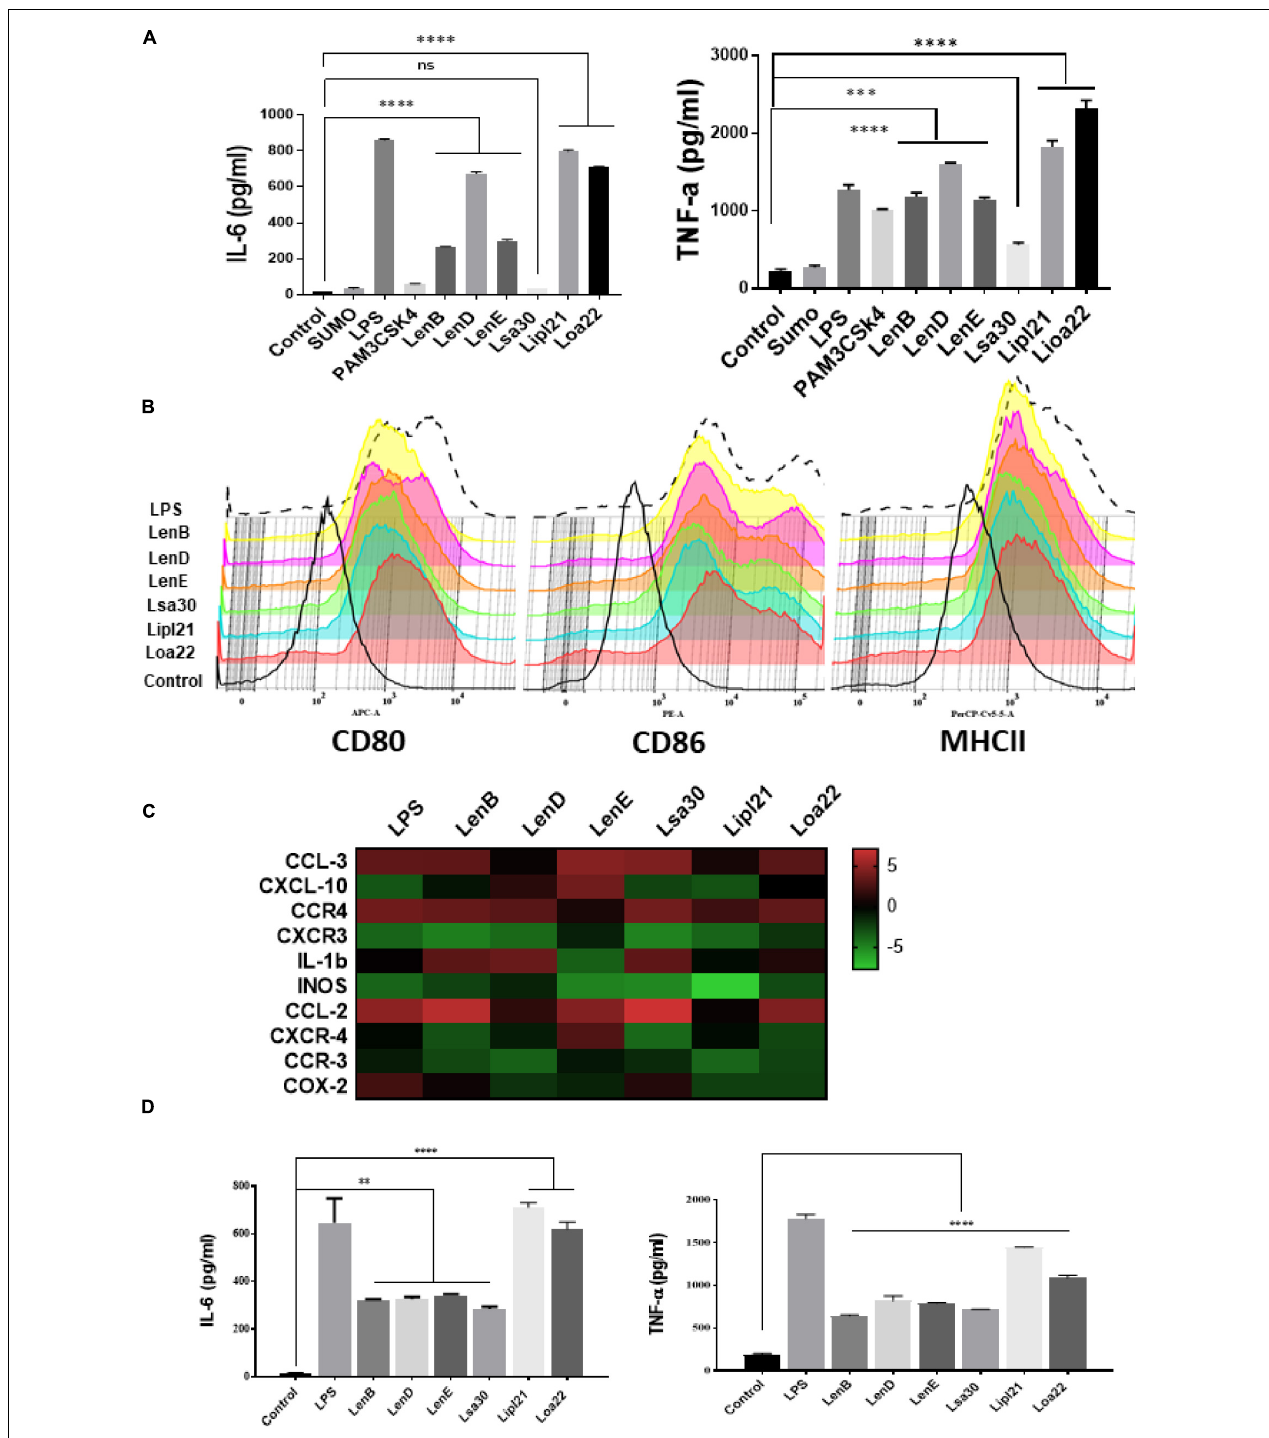
FIGURE 2 | Analysis of activation of mouse macrophages after stimulation with surface proteins. (A) Screening of pro-inflammatory response of surface proteins in RAW264.7 cells by ELISA. RAW264.7 cell lines were stimulated with LPS-treated (500 ng/ml), PAM3CSK4-treated (20 ng/ml), or PMB-treated (1 µ g/ml) rLenB, rLenD, rLenE, rLsa30, rLipl21, rLoa22, or rSUMO for 24 h at 37 ◦ C/5% CO 2 , and supernatant was collected to measure levels of IL-6 and TNF- α using sandwich ELISA kit. (B) Expression of surface markers in RAW cells after stimulation with surface proteins. RAW264.7 cell lines were stimulated with LPS-treated (500 ng/ml) or PMB-treated (1 µ g/ml) rLenB, rLenD, rLenE, rLsa30, rLipl21, or rLoa22 for 24 h at 37 ◦ C/5% CO 2 . Cells were stained with fluorochrome-conjugated antibodies against CD80, CD86, and MHCII and then analyzed by flow cytometry as described in section “Materials and Methods”. (C) Analysis of expression